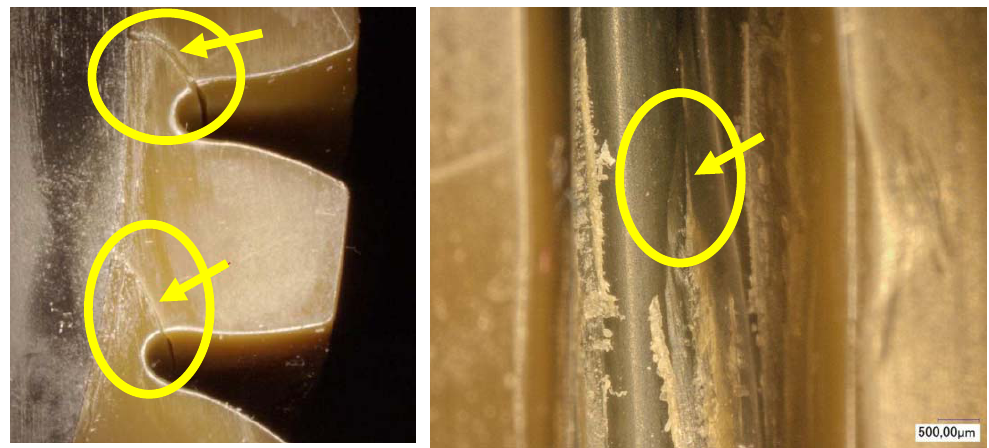
Figure 12. Fracture and crack generation in the durability